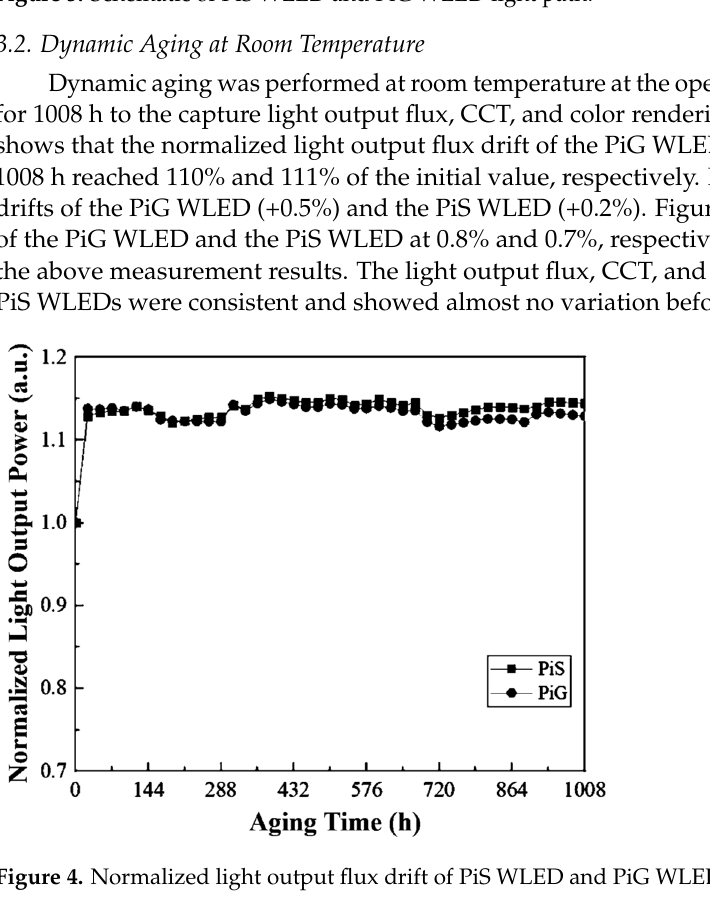
Figure 3. Schematic of PiS WLED and PiG WLED light path.